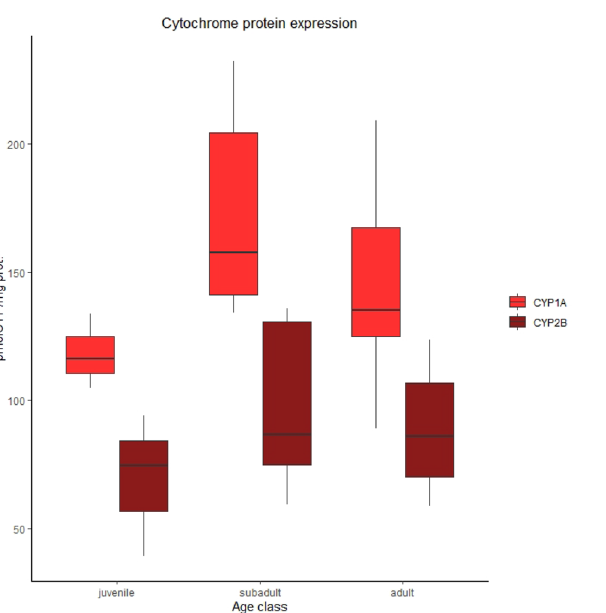
Figure 4. Contaminant concentrations for juvenile (n = 4), subadult male (n = 8), adult male (n = 6) and adult females (n = 2), in relation to ΣPCB, ΣPBDE and TEQs published toxicity threshold. ( a ) ΣPCB (mg/kg l.w.) concentrations in relation to published toxicity thresholds. The lower dotted line represents the lower toxicity threshold (9 mg/kg l.w.) published for marine mammals 18,47 . The dashed line represents the highest threshold (41 mg/kg l.w.) published for marine mammals 48 . ( b ) ΣPBDE (mg/kg l.w.) concentrations in relation to 1.5 mg/ kg l.w. published toxicity threshold 49 . ( c ) TEQ concentrations (pg WHO-TEQ/g l.w.) in relation to 210 pg WHO-TEQ/g l.w. published toxicity threshold 50 .